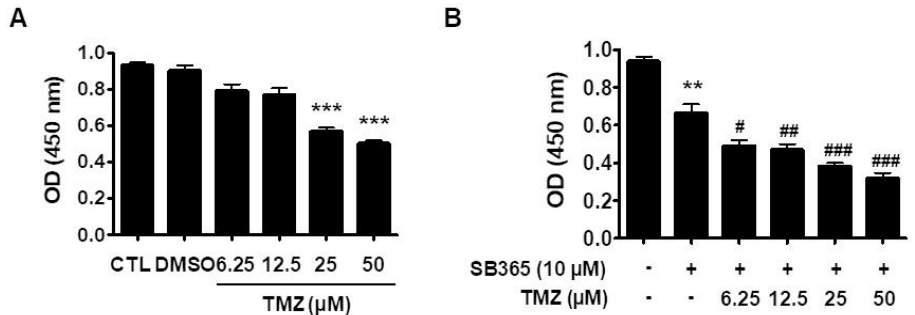
Figure 6. SB365 augmented the cytotoxic effect of TMZ on U87-MG cells. Cells were cultured in 96- well plates, treated with the indicated concentrations of TMZ in the ( A ) absence or ( B ) presence of 10 μM SB365, and subjected to CCK-8 assay. Quadruplicate samples were analyzed independently in triplicate. * p < 0.05, ** p < 0.01, and *** p < 0.001 vs the control; # p < 0.05, ## p < 0.01, and ### p < 0.001 vs the SB365 group. CTL, control; TMZ, temozolomide.